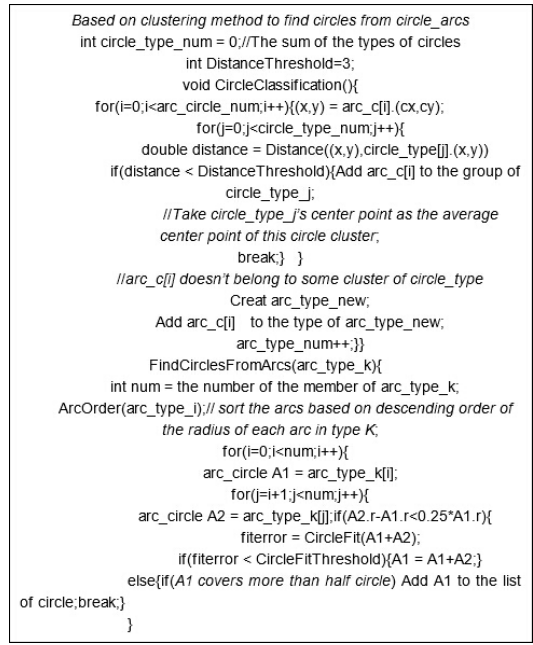
Figure 7: Algorithm to cluster arcs from available line segments.